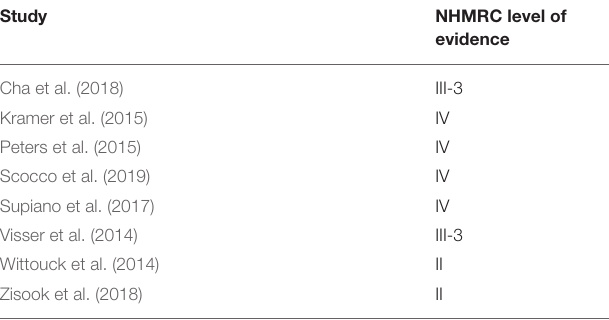
TABLE 2 | NHMRC levels of evidence.